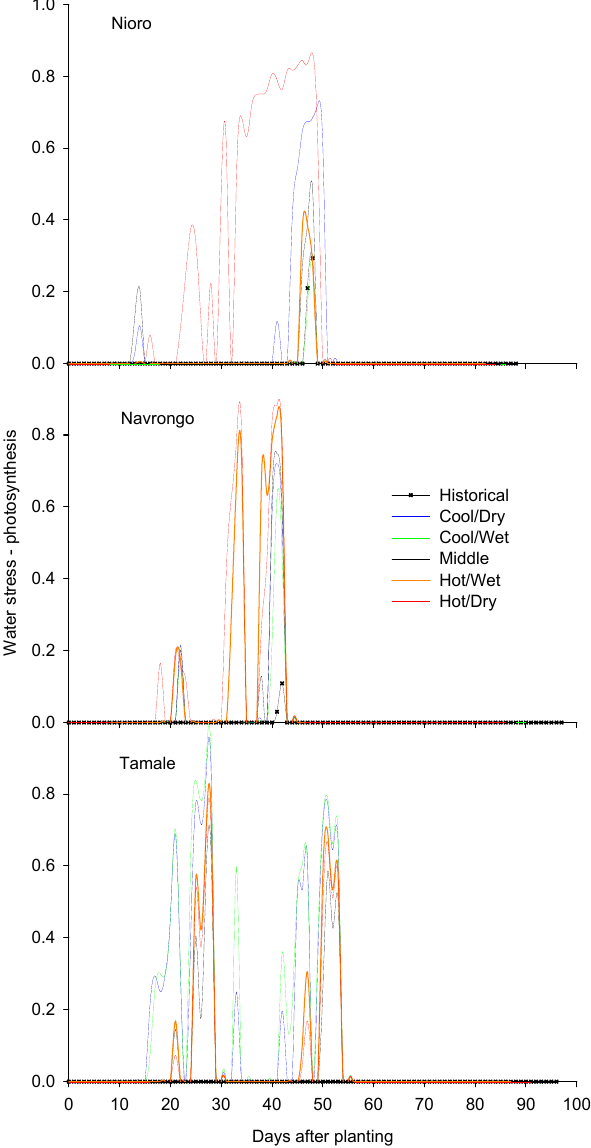
Figure 4. Simulated water stress on photosynthesis under historical climate and climate change scenarios at Nioro, Senegal, Navrongo and Tamale in Ghana. Water stress factor ranges from 1 (fully stressed) to 0 (no stress).